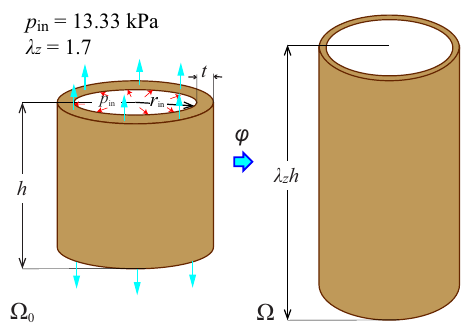
Fig. 3 Schematic of boundary conditions, initial shape, and deformed shape of arterial segment. The thick-walled cylindrical tube is assumed to have a height h of 1.85 mm with an inner radius r in of 3.70 mm and a wall thickness t of 0.77 mm as taken from the swine carotid artery (Stylianopoulos and Barocas, 2007). As boundary conditions, the axial stretch λ z is set to the approximate axial in situ stretch of a carotid artery (1.7) (Holzapfel et al., 2004), and the inner pressure p in is set to normal blood pressure (13.33 kPa).